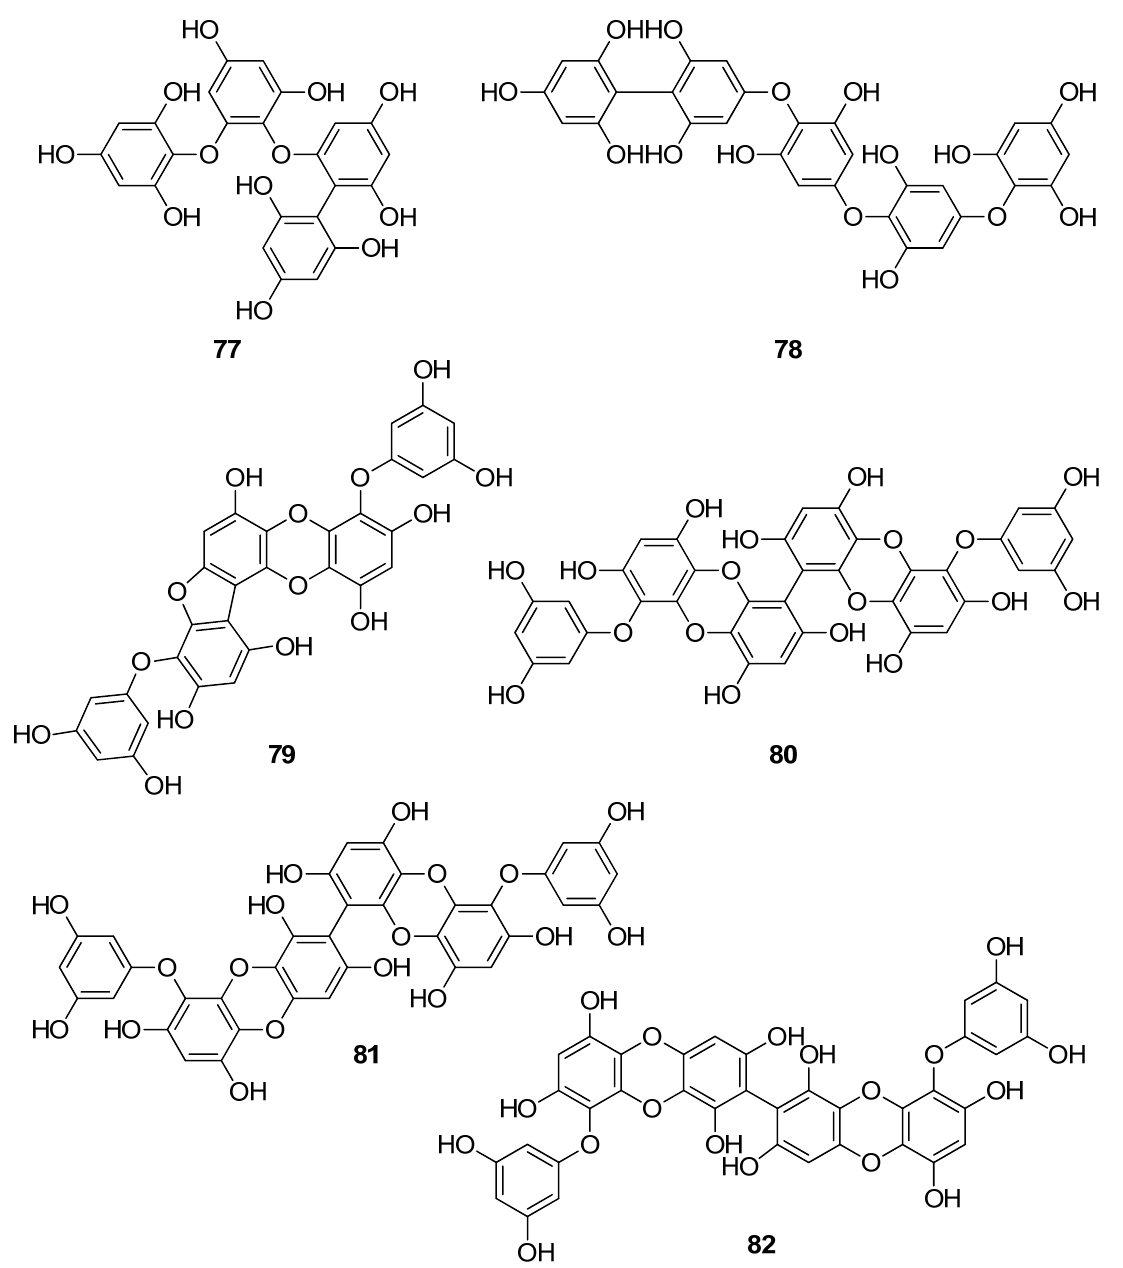
Figure 7 . Chemical structures of compounds 77 – 82 . Figure 7. Chemical structures of compounds 77 – 82